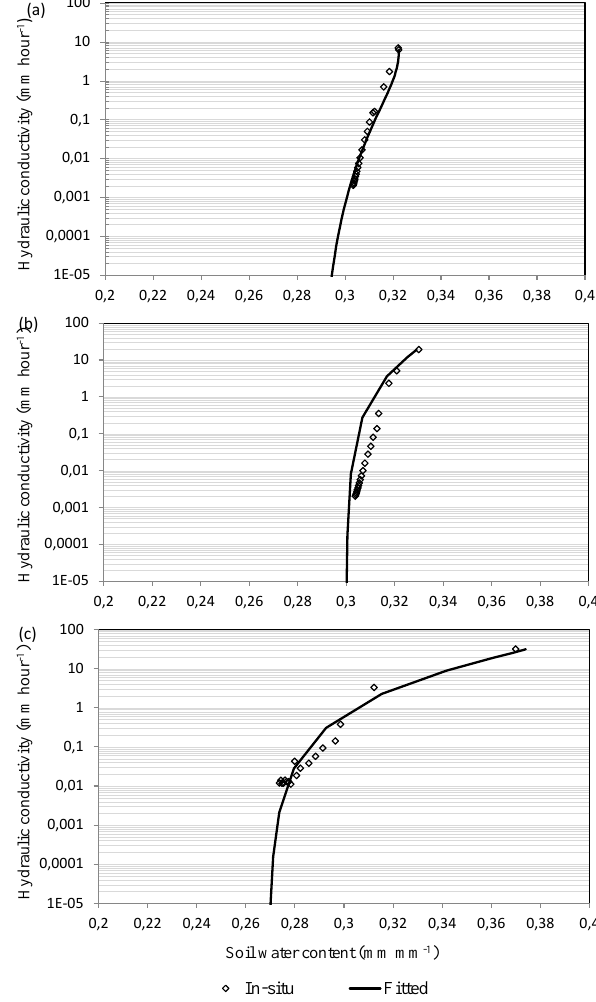
Fig. 11. Comparison of in situ and fitted hydraulic conductivity of Figure 11 Comparison of in situ and fitted hydraulic conductivity of equivalent homogeneous equivalent homogeneous soil profiles for the Tukulu, Sepane and soil profiles for the Tukulu (a), Sepane (b) and Swartland (c) soil forms. Swartland soil